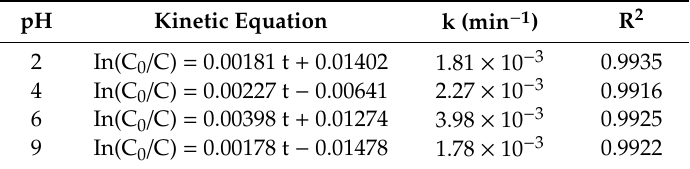
Table 6. The reaction kinetics parameters of photocatalytic of MB under di ff erent